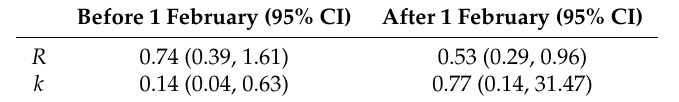
Table 3. Estimation of the reproductive number R and the dispersion parameter k for different periods.